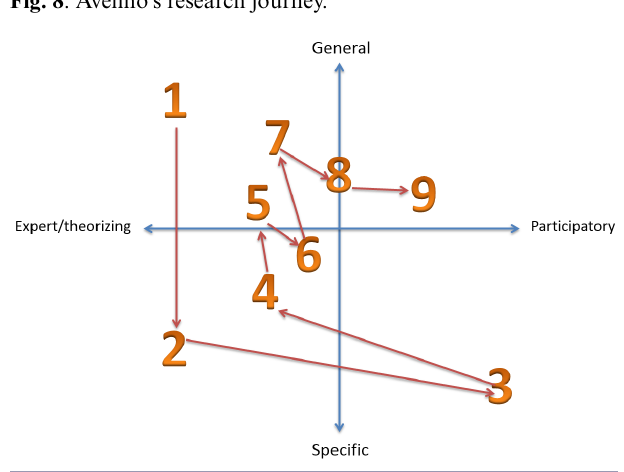
Fig. 8 . Avelino’s research